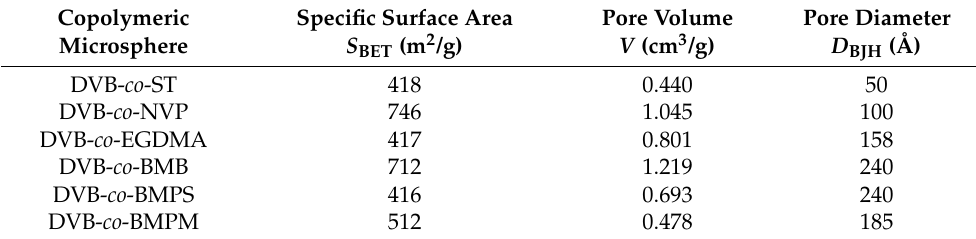
Table 3. The main parameters of the porous structure of the copolymeric microspheres.